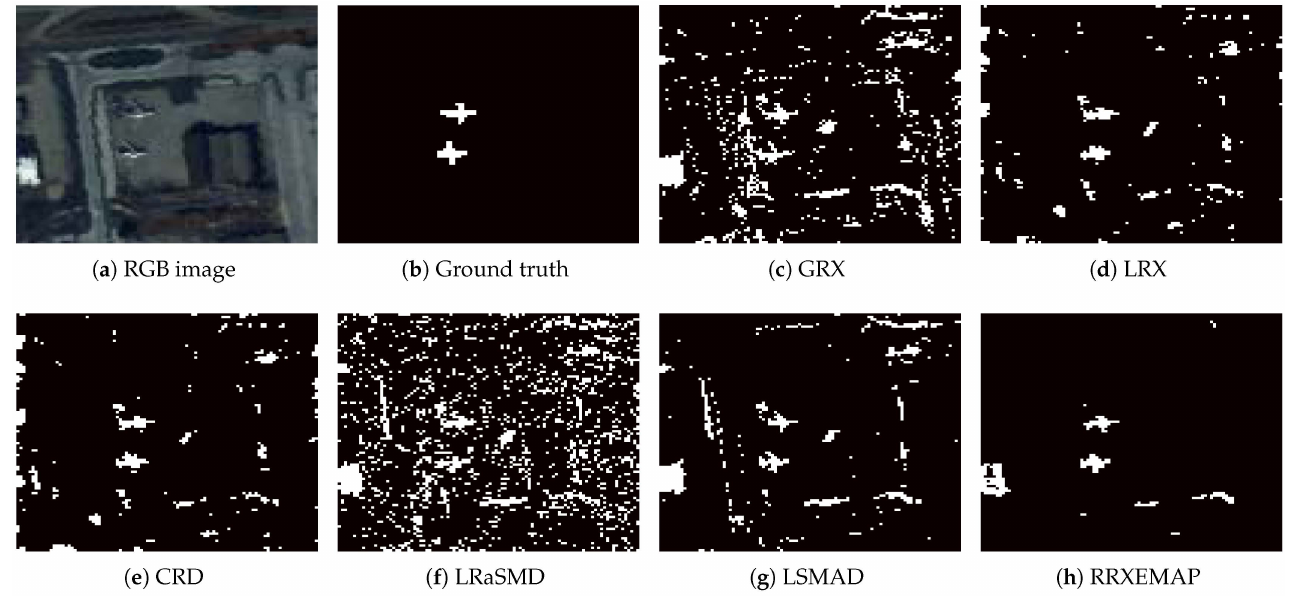
Figure 12. Color detection maps obtained by different algorithms for the abu-airport-2 dataset.